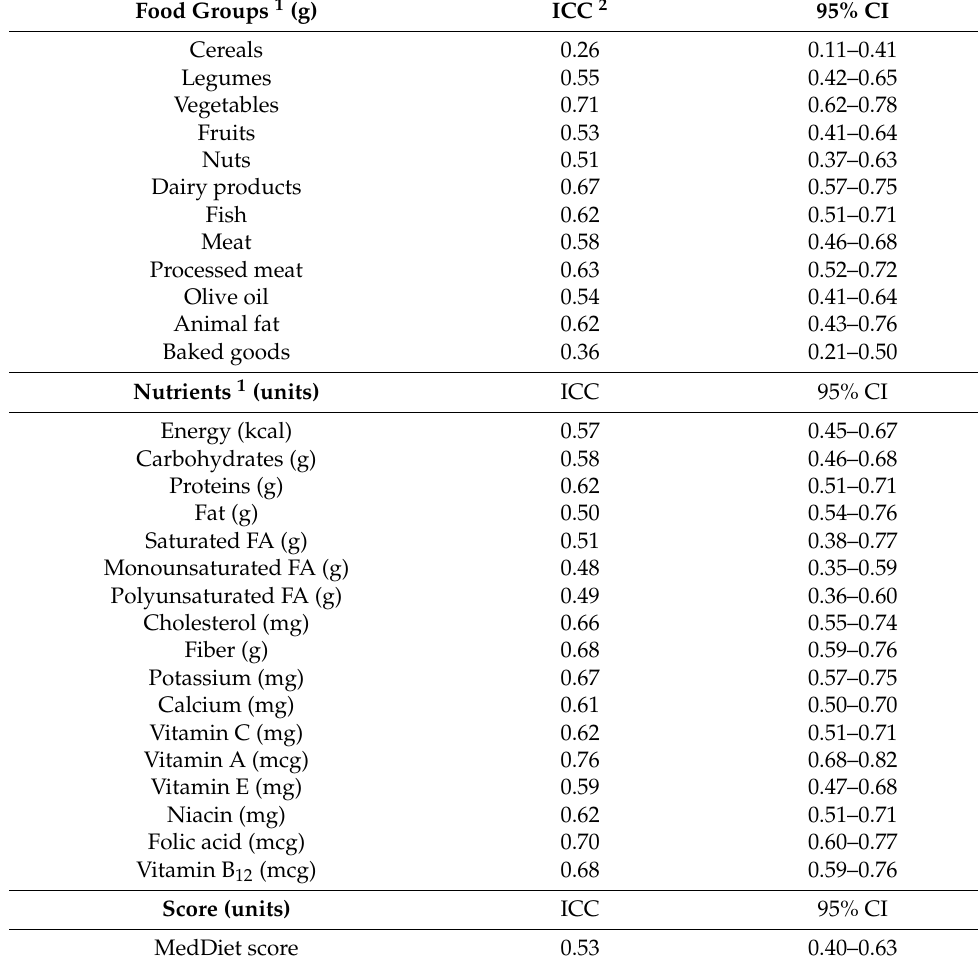
Table 2. Test–retest reliability of the food frequency questionnaire ( n = 150).